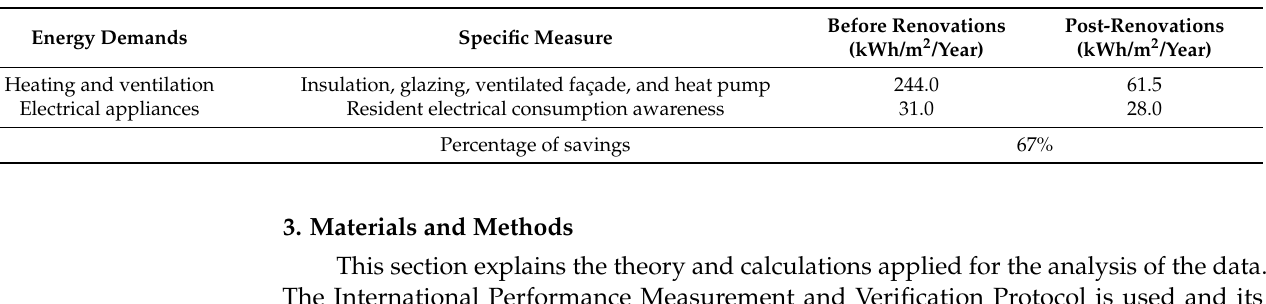
Table 2. Summary of the objective of improving energy performance in